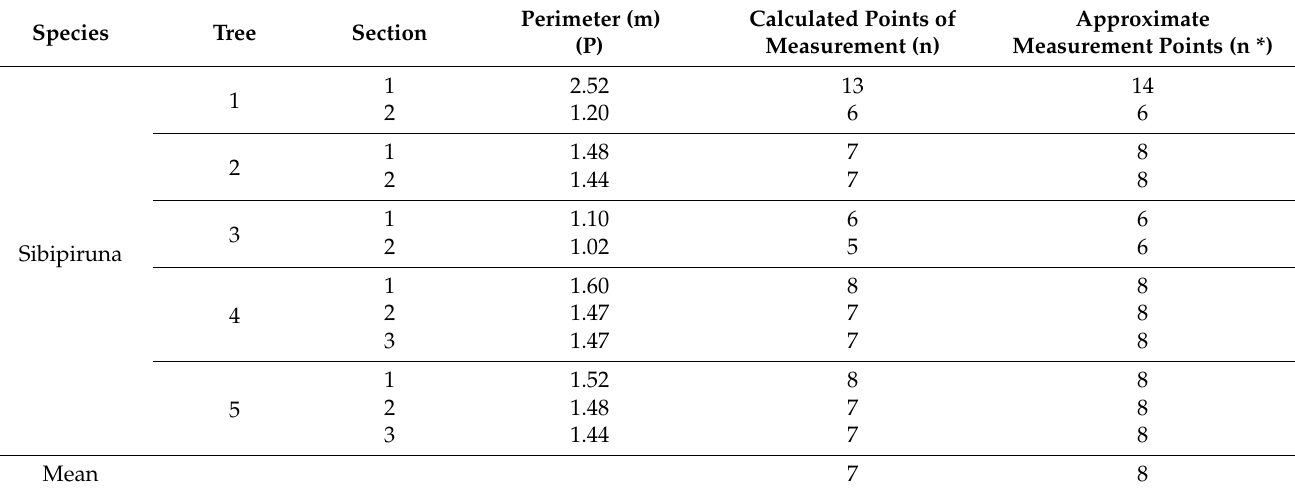
Table 1. Perimeter data of the stem sections where the trees were measured in the field and number of measurement points